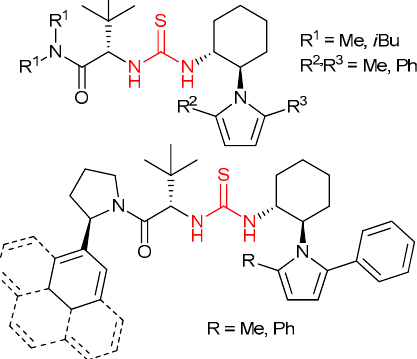
Figure 6. Modified Jacobsen’s organocatalysts.[132–134]